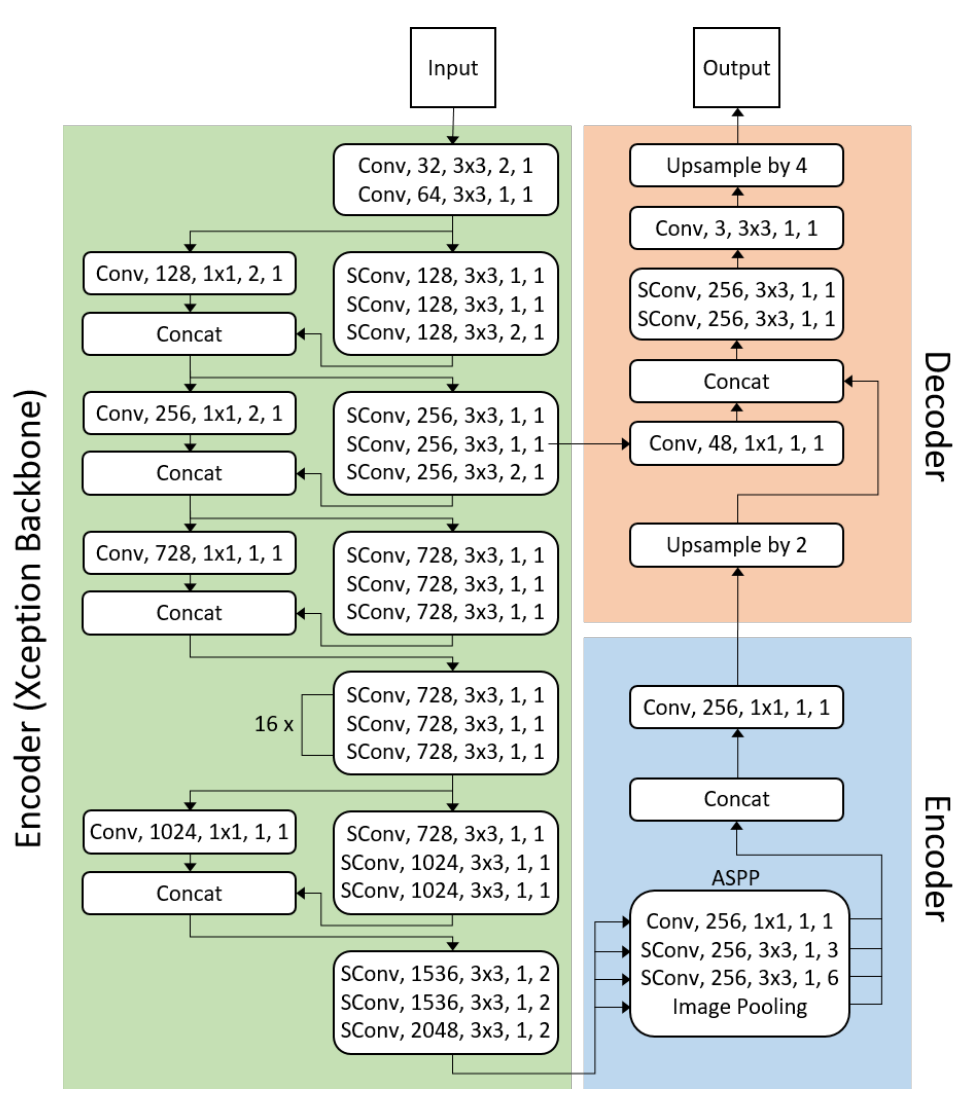
Figure 1. DLCD model diagram. The full model has a total of 40,639,856 parameters to be estimated. Layer descriptions contain: convolution type (Conv for regular convolution; SConv for depthwise separable convolution), number of filters, filter size, stride, dilation